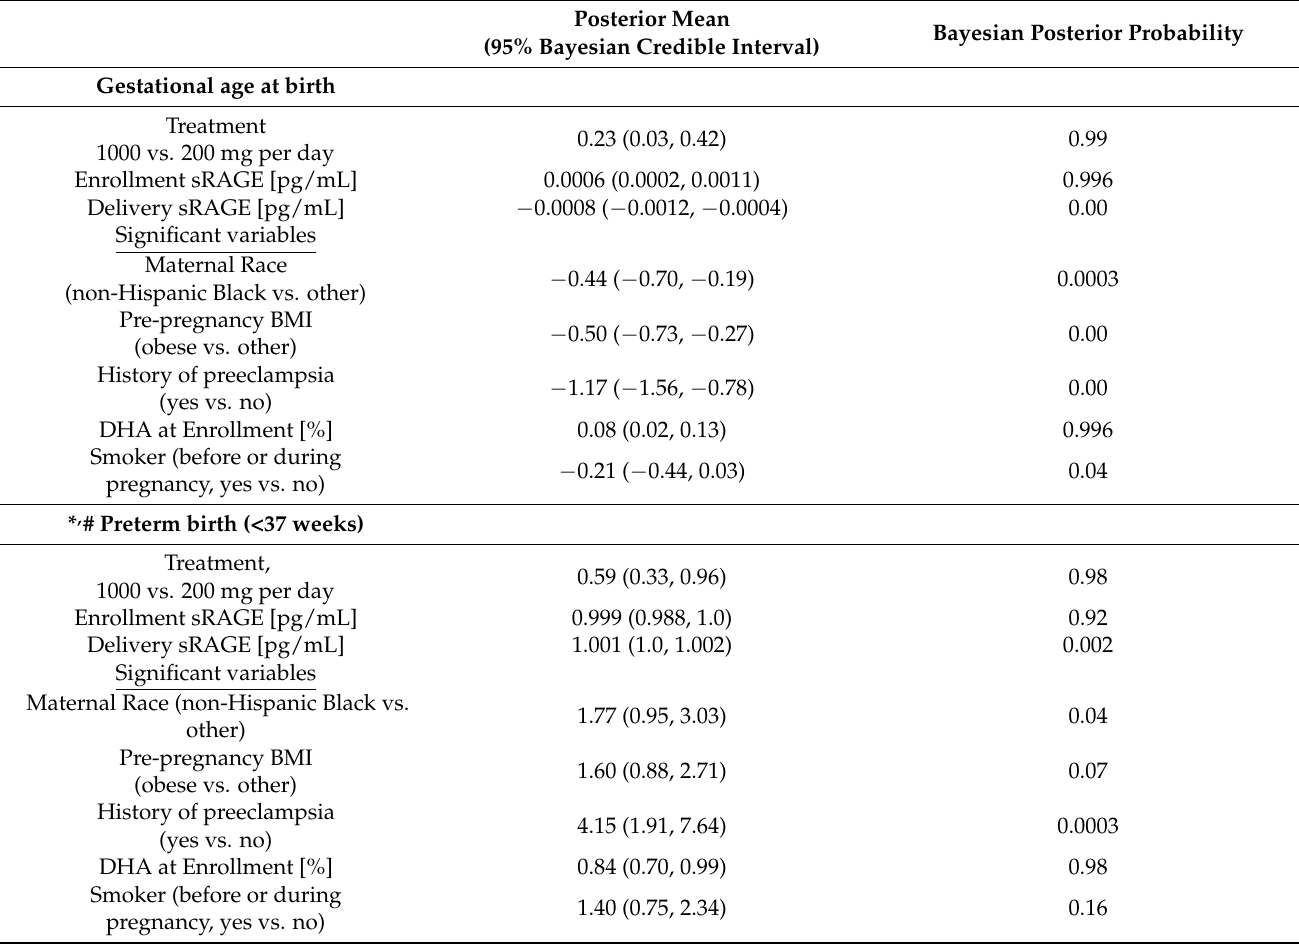
Table 2. Posterior means (Bayesian credible interval) and Bayesian posterior probability for sRAGE concentrations and the continuous variable (gestation age at birth) or the binary variable (preterm birth). The means are slopes for gestation age at birth and log-odds ratios for preterm